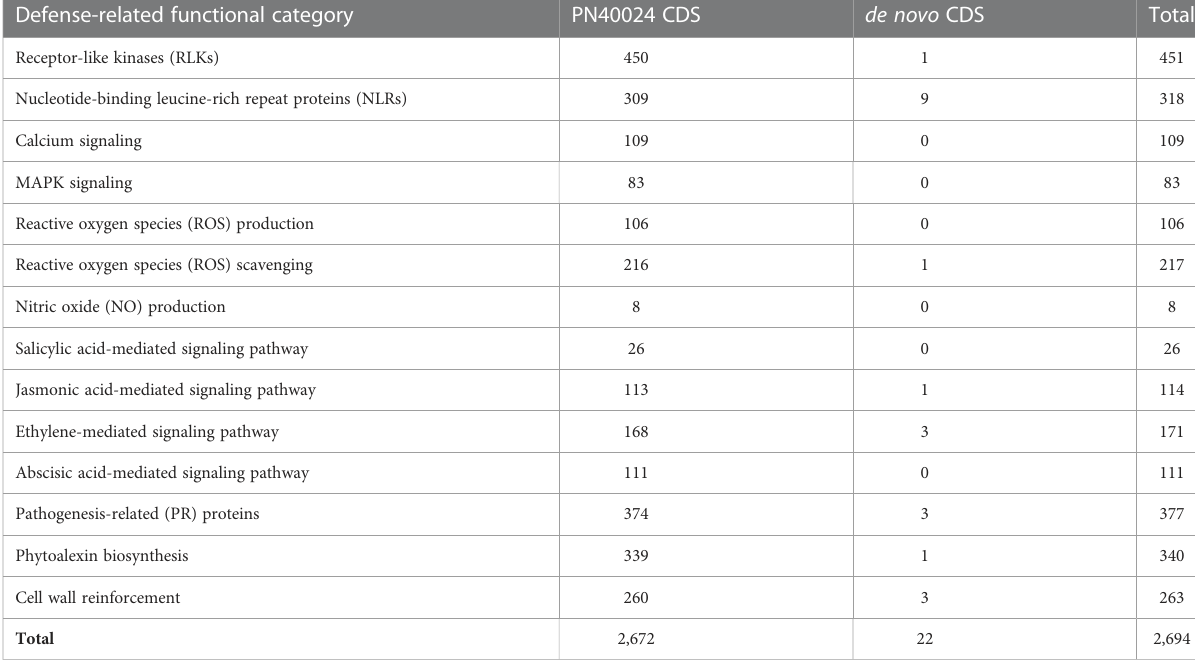
TABLE 2 Number of defense-related genes identi fi ed among the predicted proteins of PN40024 CDS and the de novo assembled CDS. Defense-related functional category